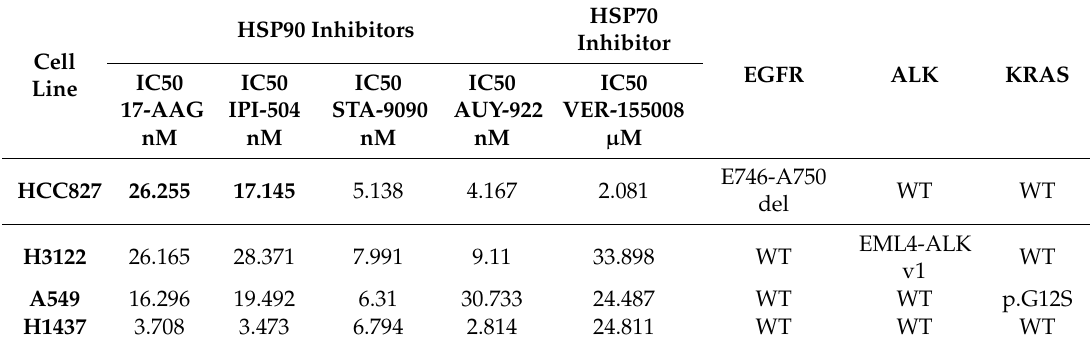
Table 1. IC50 values of di ff erent HSP90 and HSP70 inhibitors in the studied cell lines.